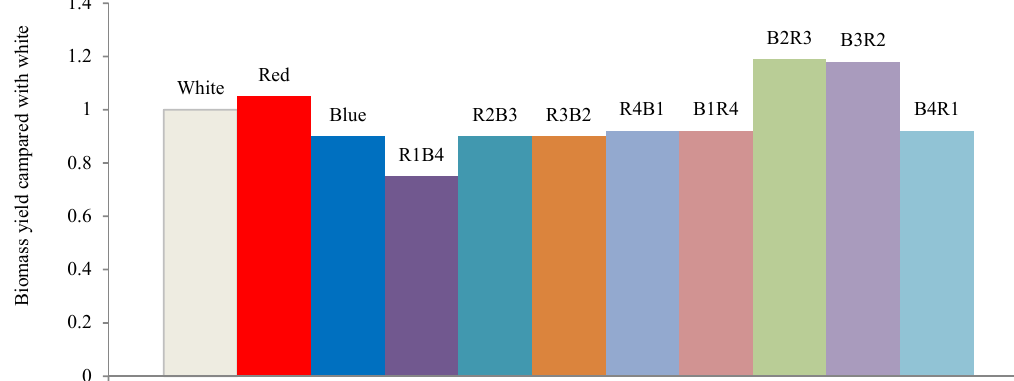
Fig. 6: Biomass production obtained with monochromatic lights and the combine wavelengths (Wang et al ., 2007)